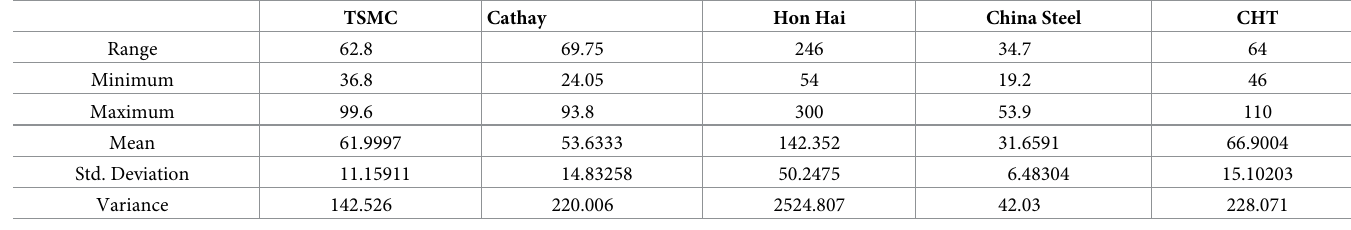
Table 15. The descriptive statistics for all datasets.